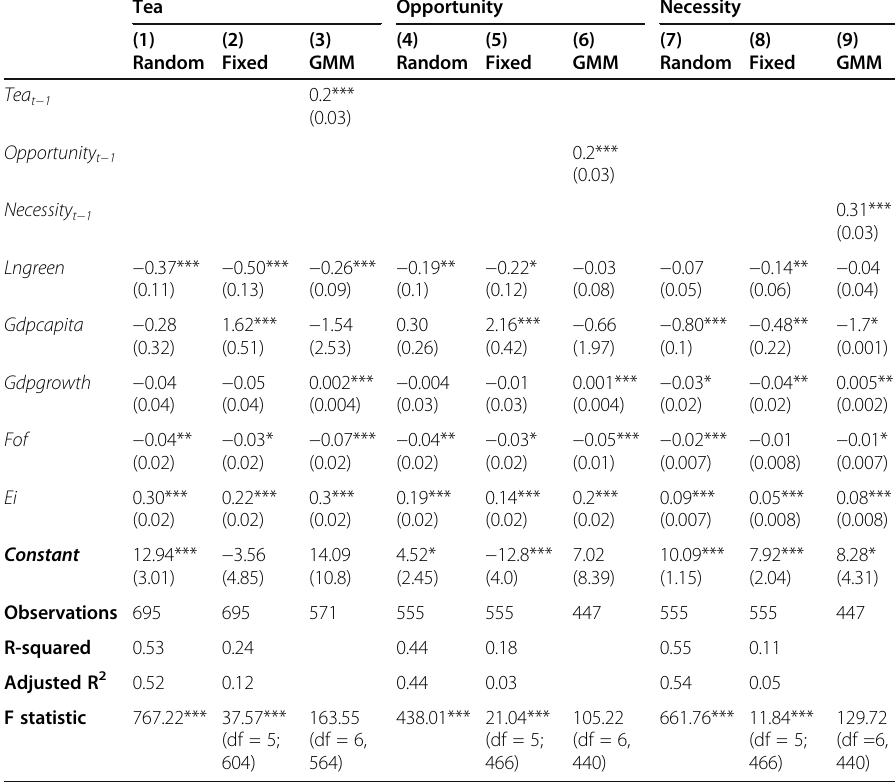
Table 3 Impact of Greenfield investment on necessity driven, opportunity-driven, and total entrepreneurial